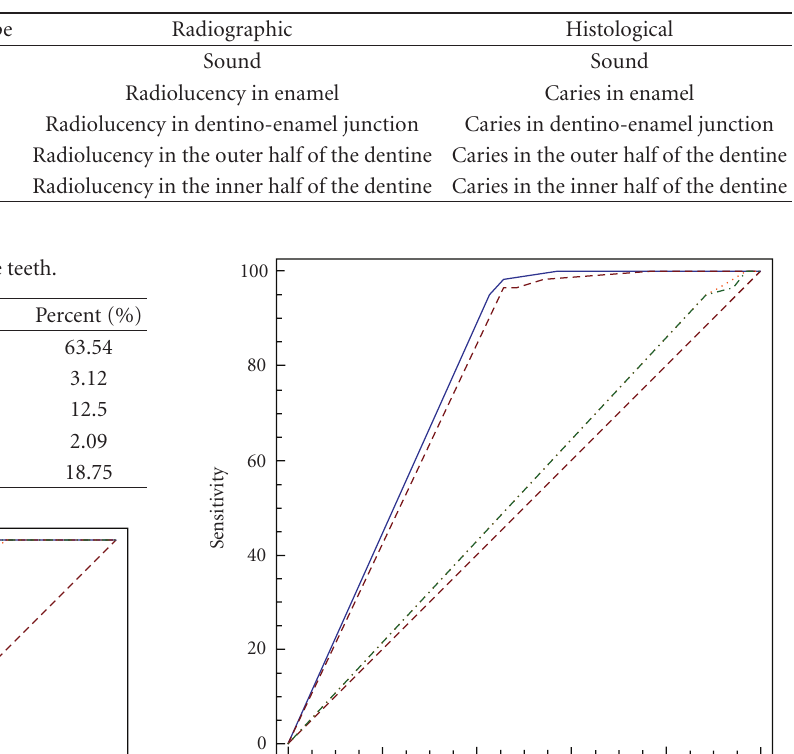
Table 1: Criteria used for evaluations.